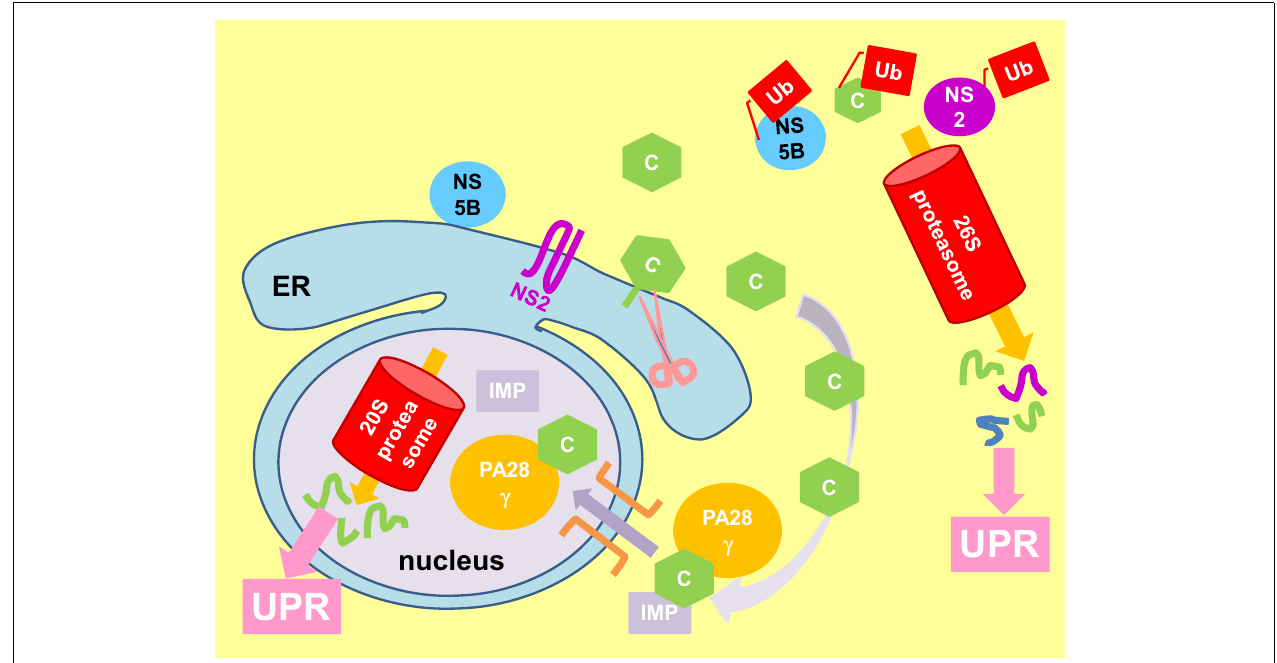
FIGURE 6 | Viral proteins perturb proteasomal function to elicit UPR. Immature core protein (C) attaches to the cytosolic side of the endoplasmic reticulum (ER) membrane by a membrane anchor. Cleavage of the membrane anchor (pink scissor) releases mature core to the cytoplasm where it can be polyubiquitinated (Ub) and degraded by the cytosolic 26S proteasome. The mature core protein can also be imported into the